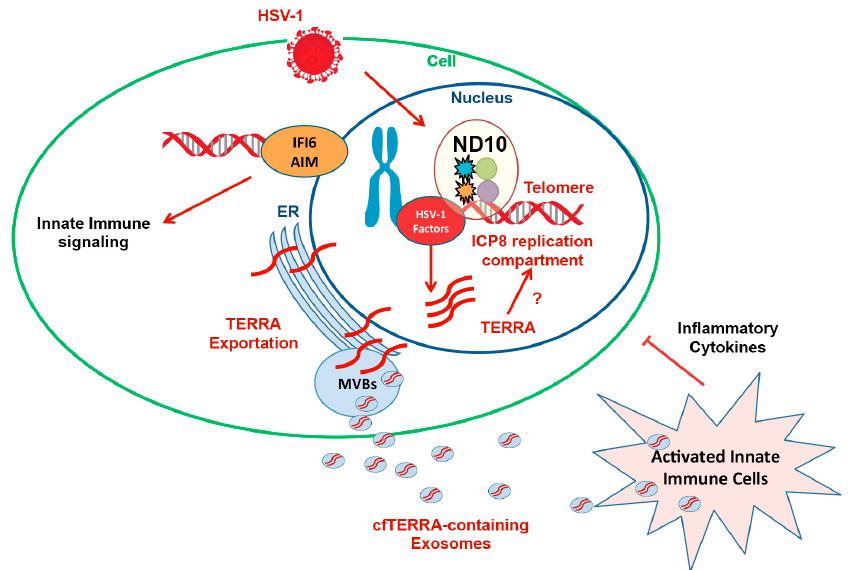
Figure 4. Innate immune response to viral infection or telomere dysfunction through the induction of TERRA. A small form of TERRA can be exported from the nucleus and cell through exosomes to stimulate inflammatory cytokine production in neighboring cells. Exosome-associated TERRA has viral-like properties including packaging and transmission. cfTERRA: Cell-free TERRA; IFI6: interferon-gamma induced protein 16; AIM2: Absent in Melanoma 2.